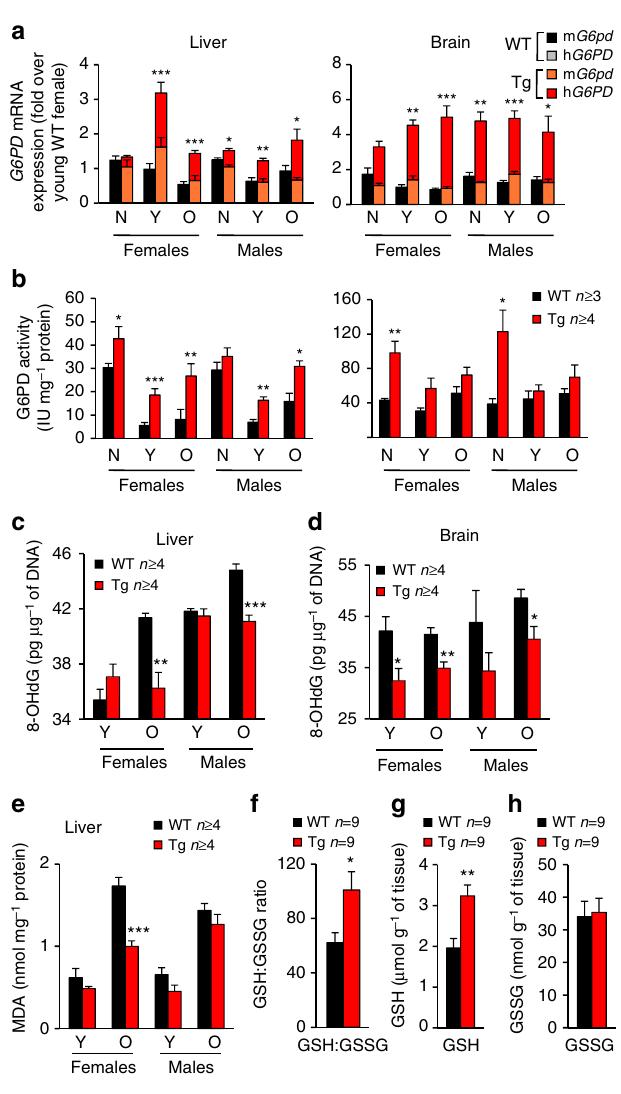
Figure 4 | Overexpression of G6PD in vivo protects from oxidative damage. ( a , b ) G6PD mRNA expression levels ( a ) and G6PD activity ( b ) in liver (left panels) and brain (right panels) of neonates, young (10–35 weeks) and old (125–143 weeks) female or male mice. For RNA measures: neonates, n ¼ 5 for all groups. Liver: young WT females, n ¼ 11; young Tg females, n ¼ 13; old WT females, n ¼ 22; old Tg females, n ¼ 22; young WT males, n ¼ 12; young Tg males, n ¼ 13; old WT males, n ¼ 13; old Tg males, n ¼ 11. Brain: young WT females, n ¼ 3; young Tg females, n ¼ 6; old WT females, n ¼ 15; old Tg females, n ¼ 15; young WT males, n ¼ 4; young Tg males, n ¼ 6; old WT males, n ¼ 6; old Tg males, n ¼ 5. For G6PD activity: neonates, n ¼ 4 for all groups. Liver: young WT females, n ¼ 8; young Tg females, n ¼ 8; old WT females, n ¼ 4; old Tg females, n ¼ 5; young WT males, n ¼ 4; young Tg males, n ¼ 4; old WT males, n ¼ 5; old Tg males, n ¼ 10. Brain: young WT females, n ¼ 3; young Tg females, n ¼ 4; old WT females, n ¼ 4; old Tg females, n ¼ 5; young WT males, n ¼ 4; young Tg males, n ¼ 4; old WTmales, n ¼ 5; old Tg males, n ¼ 4. ( c , d ) DNA oxidation (8-OHdG adducts) in liver ( c ) or brain ( d ). ( e ) Lipid oxidation (MDA adducts) in liver. ( f – h ) GSH:GSSG ratio ( f ) and GSH ( g ) or GSSG ( h ) concentrations were assayed in liver samples from 2-year-old female mice. Bars represent mean ± s.e.m. Statistical significance was assayed using the two-tailed Student’s t -test: * P o 0.05; ** P o 0.01; *** P o